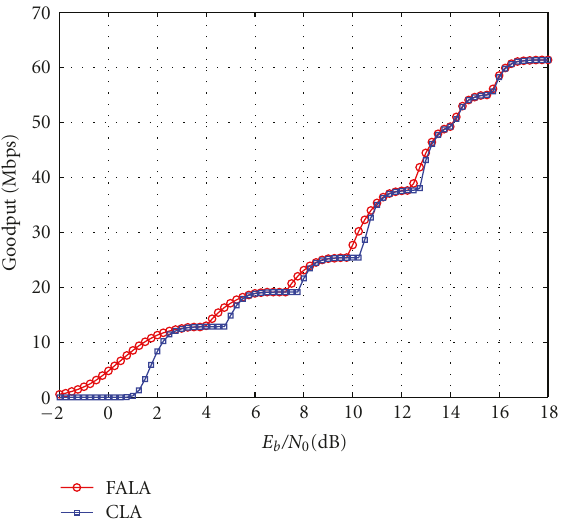
Figure 7: Performance comparison: goodput versus SNR value. The MPDU payload size for FALA algorithm l ∈ [10,5000], and MPDU payload size for CLA scheme l = 5000 bytes.